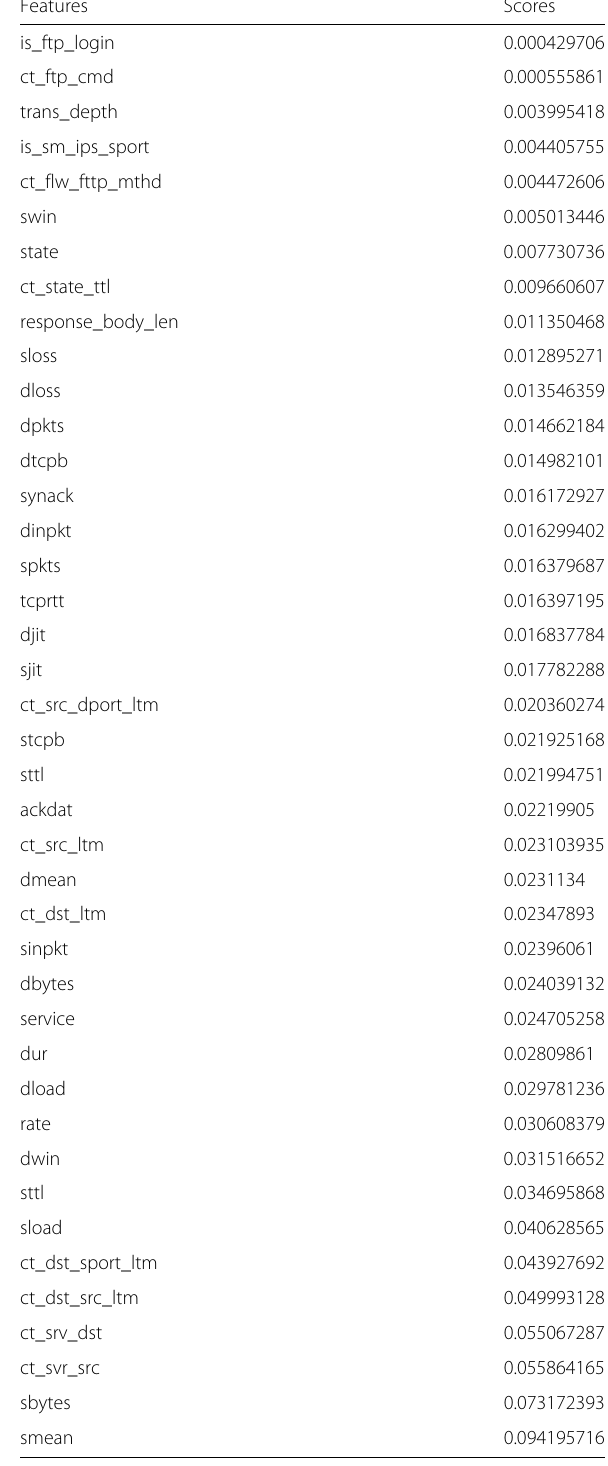
Table 4 Feature scores by ExtraTrees classifier for DoS attack in the UNSW